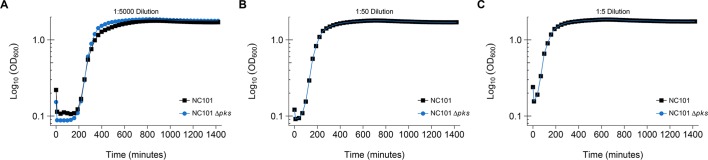
Additional dilutions used with growth curve assay.This is the same experiment as in Figure 1. In addition to 1:500 dilutions of the bacterial strains, 1:5, 1:50, and 1:5000 dilutions were also performed with OD600 measurements taken every 30 min. Representative growth curves of 3 independent biological repeats. Additional details for this experiment can be found at https://osf.io/54rgt/.